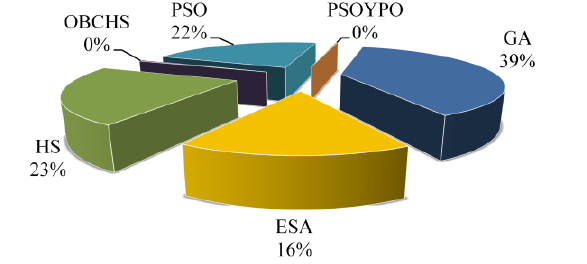
Figure 5. Comparison of STD results for